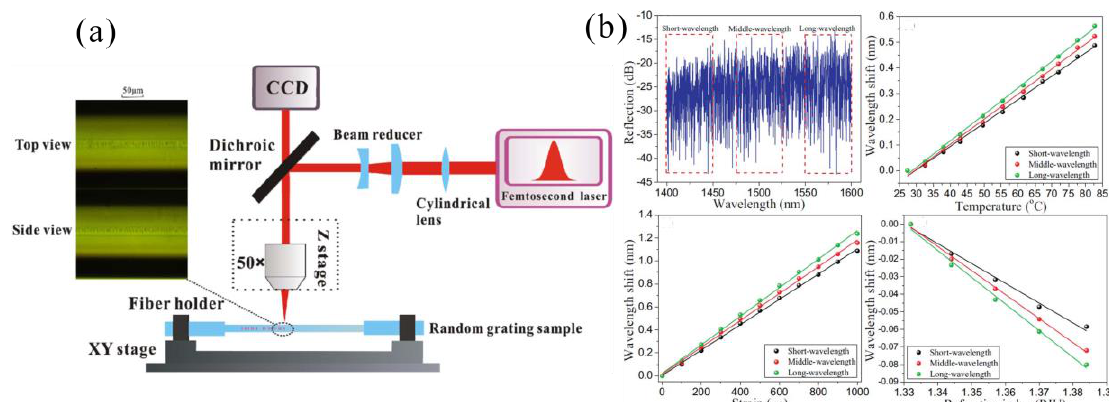
Figure 17. ( a ) Experimental setup of the fs laser micro-machining system with microscopic images of the fiber random grating samples; ( b ) Three spectrum subsections selected in the reflection spectrum of fiber-optic random grating; cross-correlation peak wavelength shift calibration results for temperature, strain, and refractive index [260].